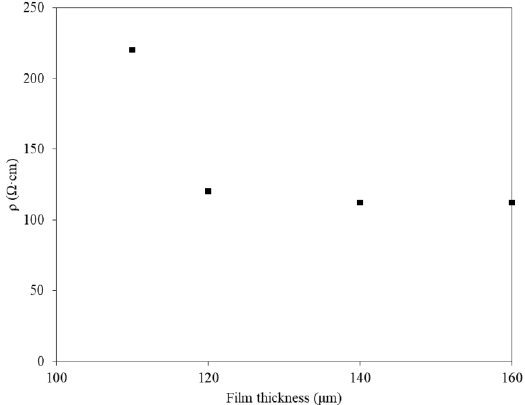
Figure 4. Thickness dependence of the electrical resistivity of the PANI films on a polyethylene substrate.